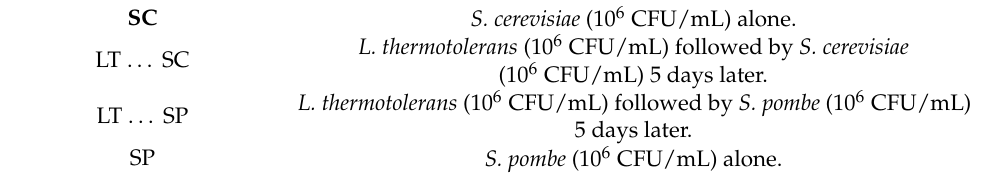
Table 1. Must inoculum compositions. SC S. cerevisiae (10 6 CFU/mL)